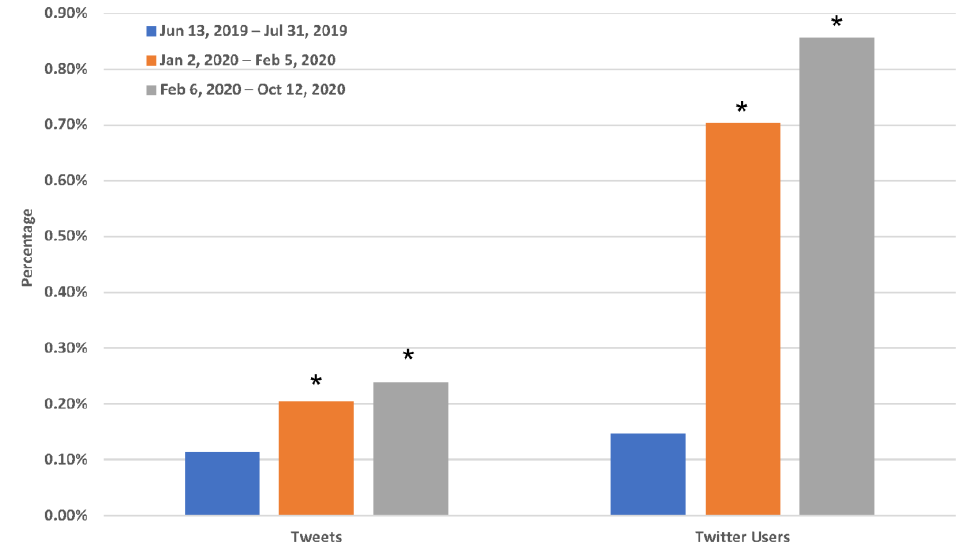
Figure 1. Changes in the proportion of tweets and Twitter users mentioning quitting vaping after the announcement and implementation of the FDA flavor enforcement policy.